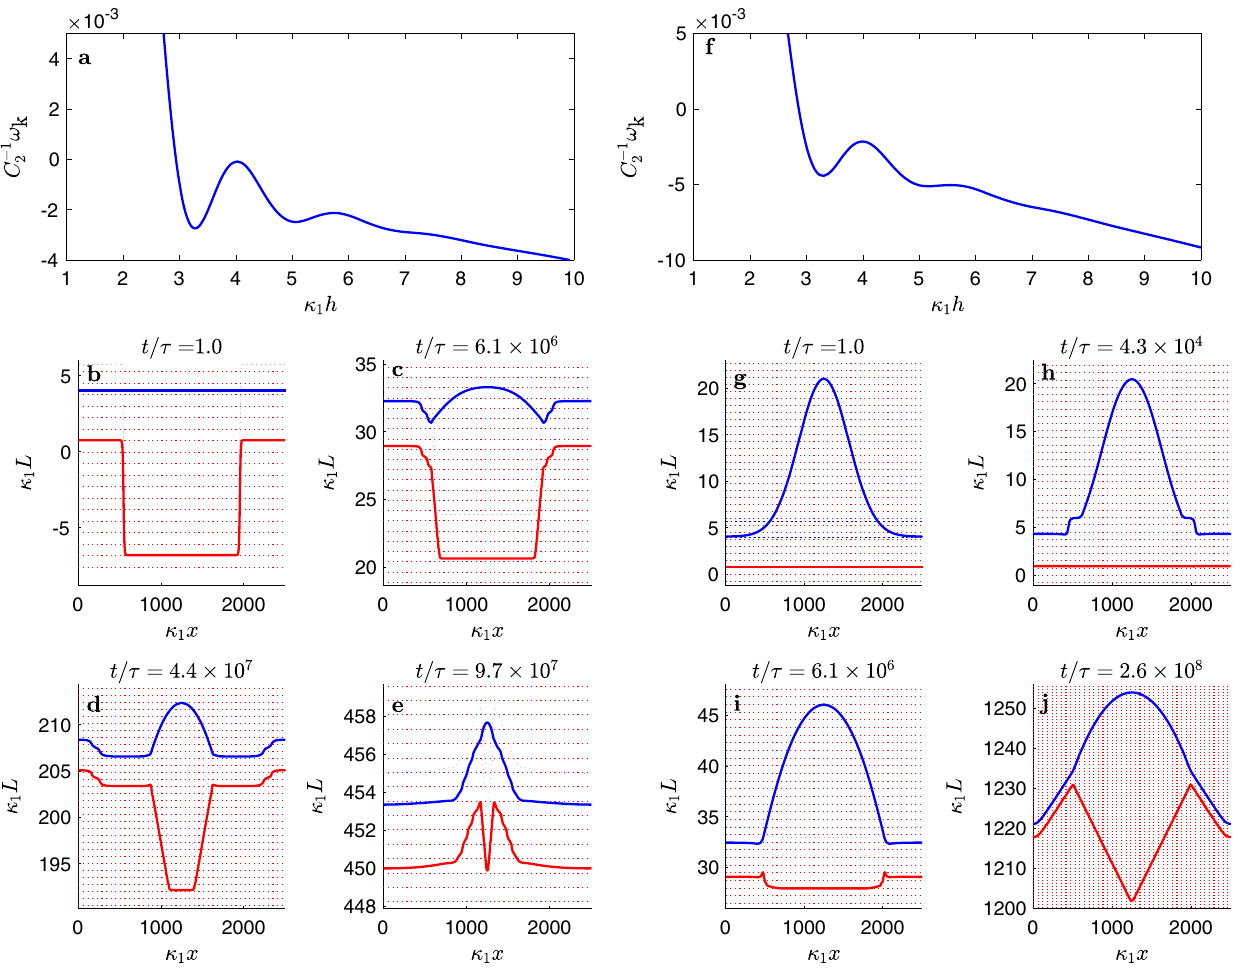
Fig. 5 Surface dynamics above the kinetic coexistence line. Panels a and f show the effective free energies, ω k ( h ) that drive the time evolution of the ice surface at state points depicted as a triangle ( △ ) and a square ( □ ) in Fig. 3, respectively. Panels b – e and g – j show solid/liquid and liquid/vapor surfaces at signi fi cant milestones of the dynamics as described in Fig. 4. Panels a – e display the evolution of a surface defect at state point ( p , T ) = (517.5 Pa, 269.5 K) (shown as a triangle ( △ ) in Fig. 3). The growth of a thick wetting fi lm is now favorable, as illustrated by the negative slope of the effective free energy in panel a . A defect on the solid/liquid surface (panel b ) triggers the formation of a liquid droplet (panel c ). Ice then grows inside the droplet, forming a large crater (panels d – e ) which vanishes eventually when the ice surface catches up with the liquid droplet and attains a stationary premelting layer thickness (Supplementary Movie 3). Panels f – j display the evolution of a droplet at ( p , T ) = (518.5 Pa, 269.5 K) above the kinetic α → β transition line (shown as a square ( □ ) in Fig. 3). Here, the β state has lower free energy than the α state, as illustrated in panel f . During the time evolution of a droplet (panel g ), a thick fi lm of β thickness forms at the rim transiently (panel h ), then the droplet evolves a crater (panels i – j ) as the ice surface catches up with the droplet (Supplementary Movie